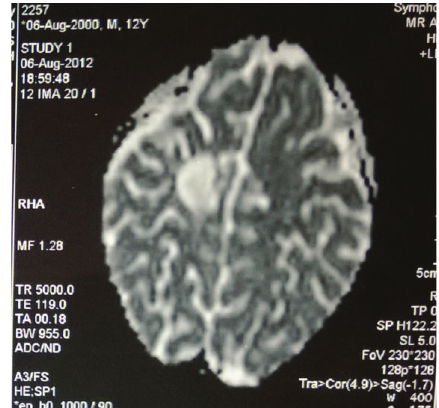
Figure 11: CT scan residual tumor 2012.